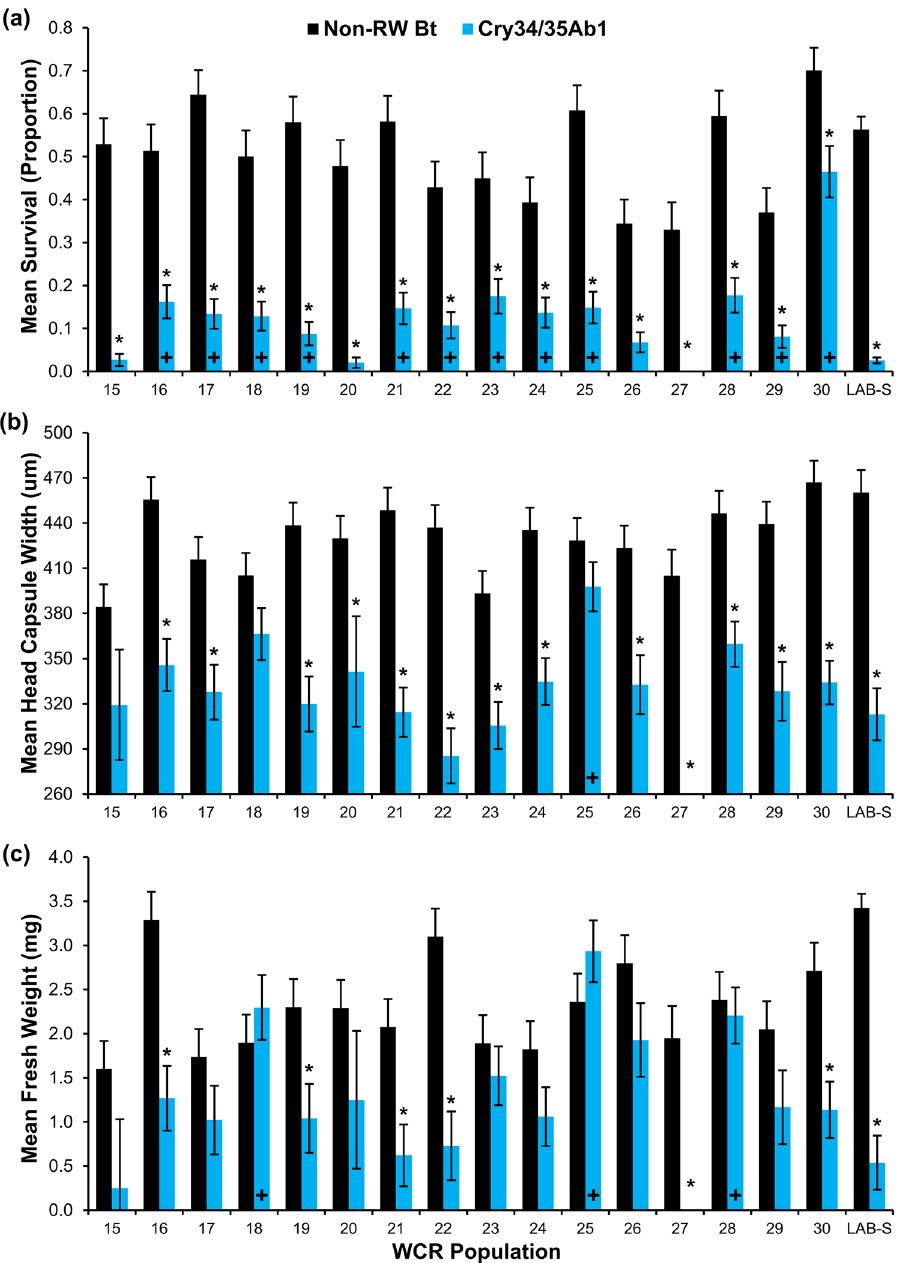
Figure 3. Larval survival and development of western corn rootworm populations bioassayed on non- rootworm Bt and Cry34/35Ab1 maize in 2020. ( a ) Mean proportional survival (± SE), ( b ) mean head capsule width (± SE), and ( c ) mean fresh weight (± SE). Asterisks above Cry34/35Ab1 bars indicate significantly lower survival or development compared to the non-rootworm Bt hybrid within a population (Tukey’s multiplicity adjustment, p < 0.05). A ‘+’ within Cry34/35Ab1 bars indicates significantly greater survival or development on Cry34/35Ab1 maize relative to the susceptible laboratory control (Dunnett’s test, p <